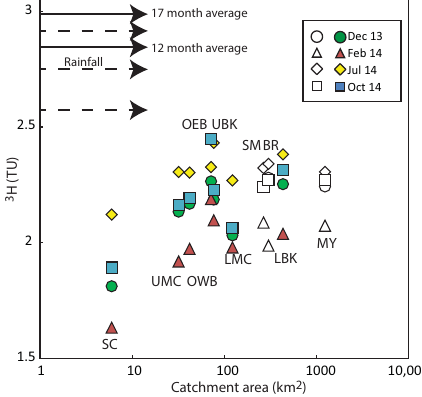
Figure 5. 3 H activities vs catchment area for the main Ovens River (open symbols) and its headwater tributaries (closed sym- bols) and the range of rainfall 3 H activities (aggregated rainfall samples shown by solid arrows, other rainfall samples by dashed arrows); data from Table 1. BR = Bright, LBK = Lower Buckland, LMC = Lower Morses Creek, MY = Myrtleford, OEB = Ovens East Branch, OWB = Ovens West Branch, SC = Simmons Creek, SM = Smoko, UBK = Upper Buckland, UMC = Upper Morses Creek. Precision of 3 H activities (Table 1) is approximately the size of the